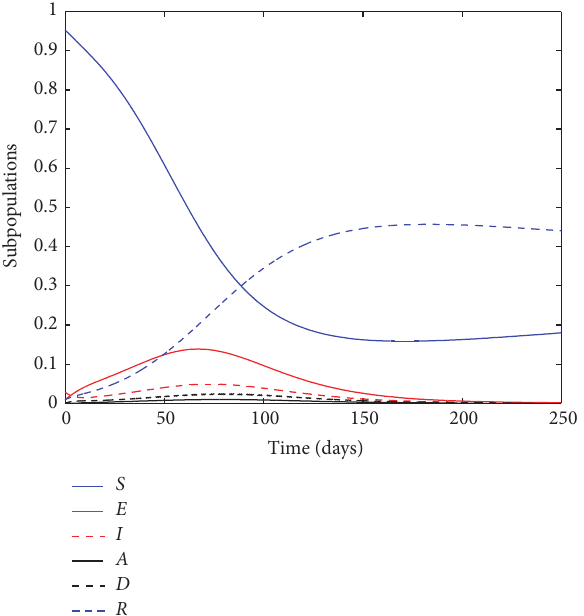
Figure 16: Evolution of the subpopulations with daily culling rate of = 0.1 and feedback vaccination of 𝑉 = 0.2𝑏 𝜌 𝐷